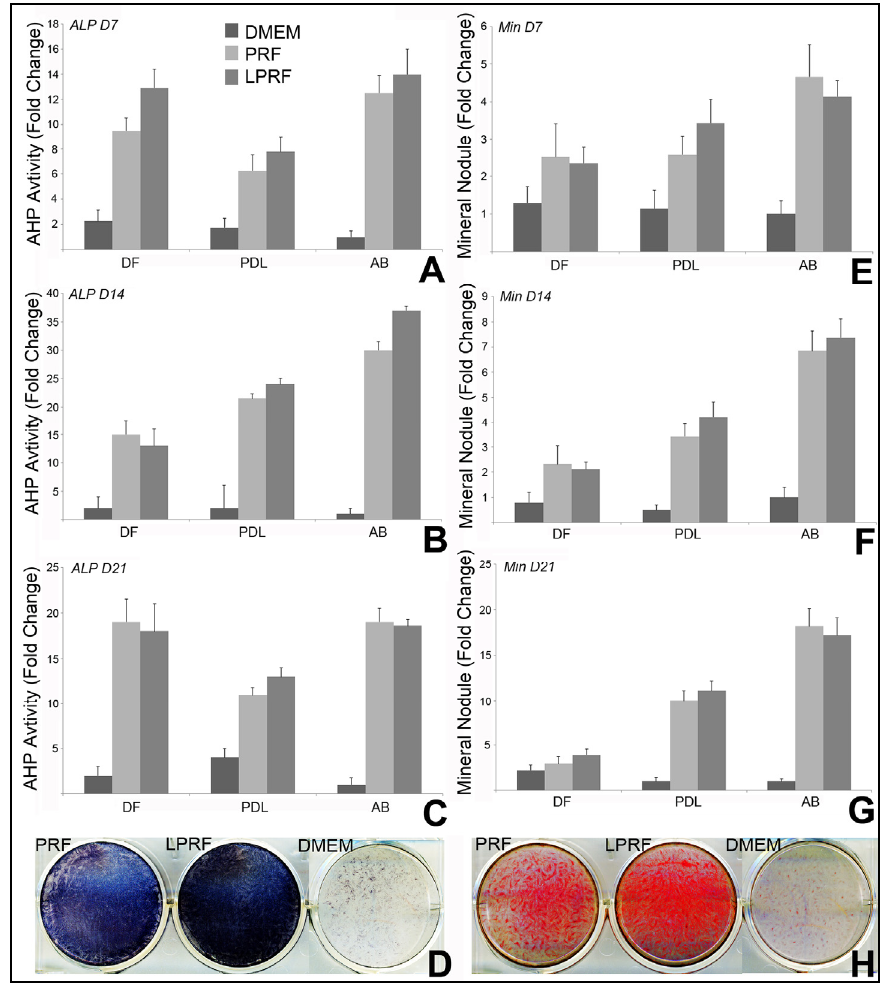
Figure 3. Effect of fresh and lyophilized PRF, and DMEM medium on mineralization behavior of periodontal progenitor populations. ( A – D ) are based on results from alkaline phosphatase staining assays and ( E – H ) are based on alizarin red S mineralization